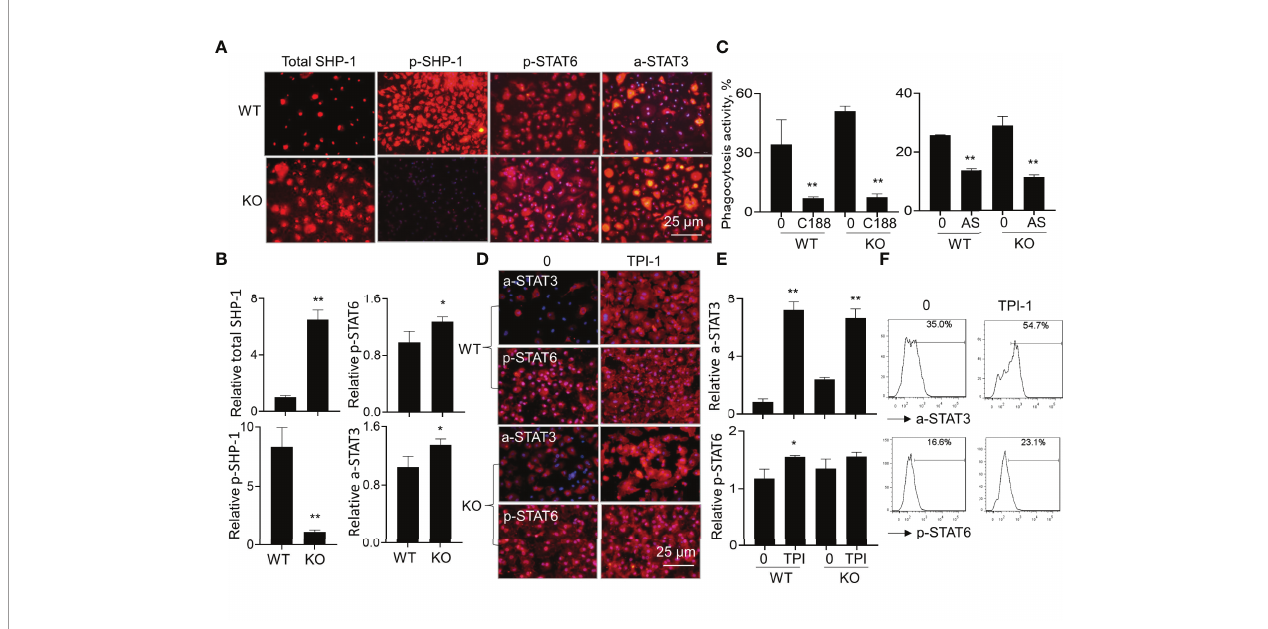
FIGURE 8 | Lack of SIRP-alpha improved macrophage phagocytosis through STAT3 and STAT6 signaling pathways. (A) Immunostaining for total SHP-1, phosphorylated SHP-1 (p-SHP-1), phosphorylated STAT6 (p-STAT6) and acetylated STAT3 (a-STAT3) in WT and KO BMDMs 12 hours after LPS treatment. Red: positively stained cells. Representative photograph, 200 × magni fi cation. (B) Quantitative analysis for total SHP-1, p-SHP-1, p-STAT6 and a-STAT3 by ImageJ software. Data was presented as mean relative fl uorescence intensity over WT BMDMs ± standard deviation, *p < 0.05, **p < 0.01 vs. WT group, n=3, 2-tailed student ’ s t test. (C) Phagocytosis activity of WT or KO BMDMs treated by 5 m M C188-9 (STAT3 inhibitor) or 5 m M AS1517499 (STAT6 inhibitor). The untreated cells were controls. Data was presented as mean ± standard deviation, **p < 0.01 vs. untreated cells, n=3. (D) Immunostaining for a-STAT3 and p-STAT6 in WT or KO BMDMs after treatment with 5 µM TPI-1 (SHP-1 inhibitor) or untreated. Red: positively stained cells, representative photograph, 200 × magni fi cation. (E) Quantitative analysis of a-STAT3 and p-STAT6 in TPI-1 treated WT or KO BMDMs by ImageJ software. Data was presented as mean relative fl uorescence intensity over untreated WT BMDMs ± standard deviation, *p < 0.05, **p < 0.01 vs. untreated cells, n=3. One-way ANOVA followed by Tukey ’ s multiple comparisons test. (F) Flow cytometry analysis for a-STAT3 and p-STAT6 in the untreated or TPI-1 treated WT BMDMs. Representative